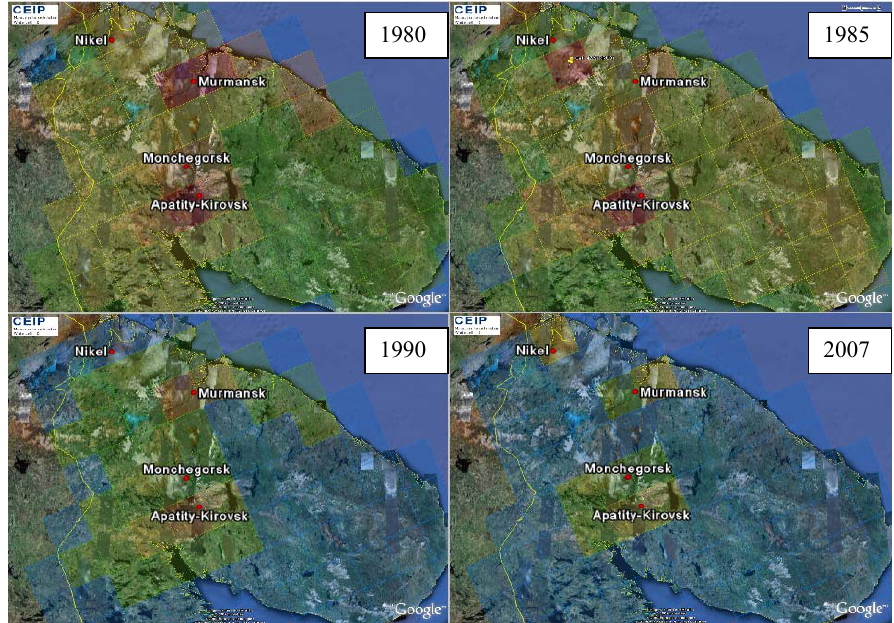
Figure 2. The original EMEP emission for 1980-2007, WebDab status 2010. The 50km grid Fig. 2. The original EMEP emission for 1980–2007, WebDab status 2010. The 50km grid cells are shown with the colours reflecting cells are shown with the colours reflecting the SOx emission: blue <= 0.1 kTon year-1 SO2, the SO x emission: blue < =0.1kTonyr − 1 SO 2 , green < =1kTonyr − 1 SO 2 , yellow < =10kTonyr − 1 SO 2 , orange < =100kTonyr − 1 SO 2 , green <= 1 kTon year-1 SO2, yellow <= 10 kTon year-1 SO2, orange <= 100 kTon year-1 red > 100kTonyr − 1 SO 2 . Pictures from http://www.ceip.at. SO2, red > 100 kTon year-1 SO2. Pictures from http:// www.ceip.at.